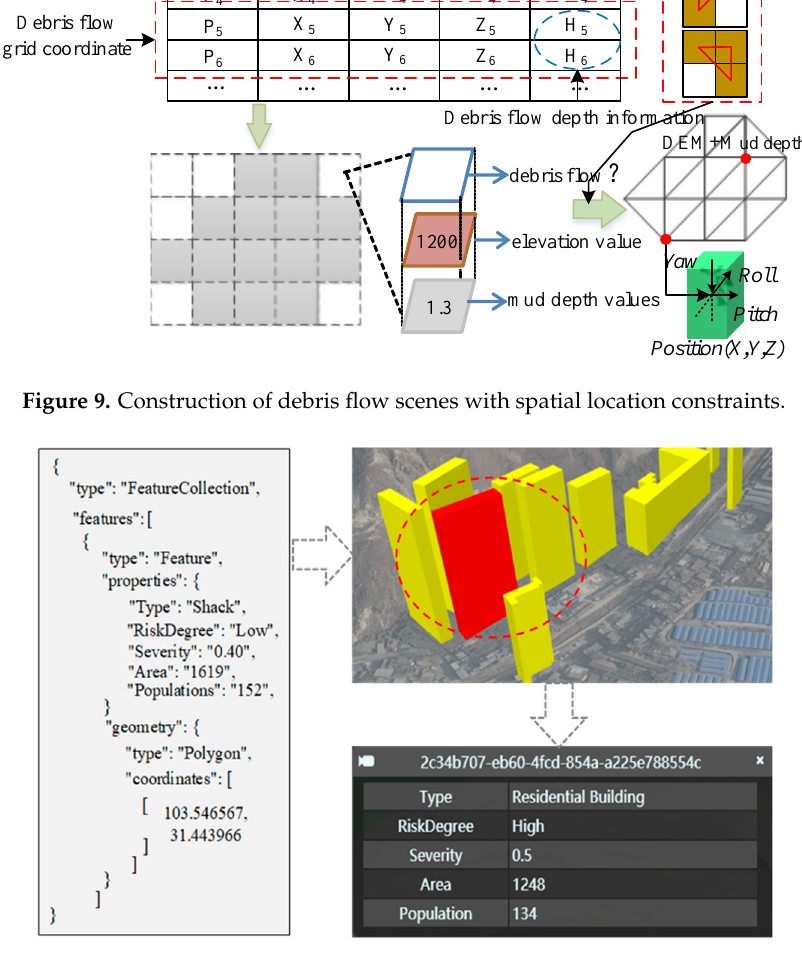
Figure 10. Attribute information fusion of residential buildings in risk.